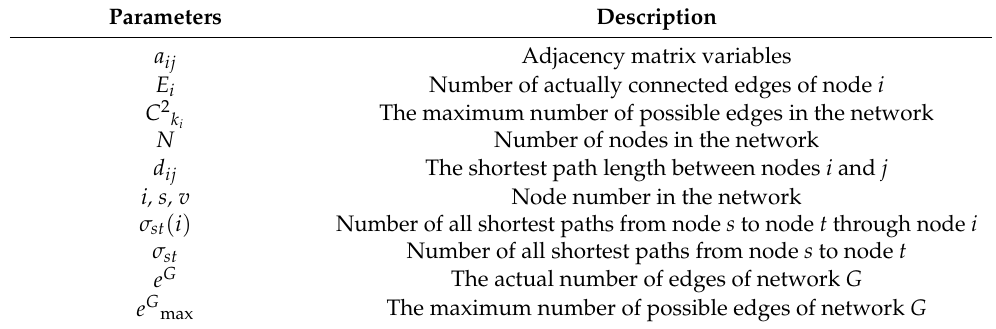
Table 2. Description of formula parameters.